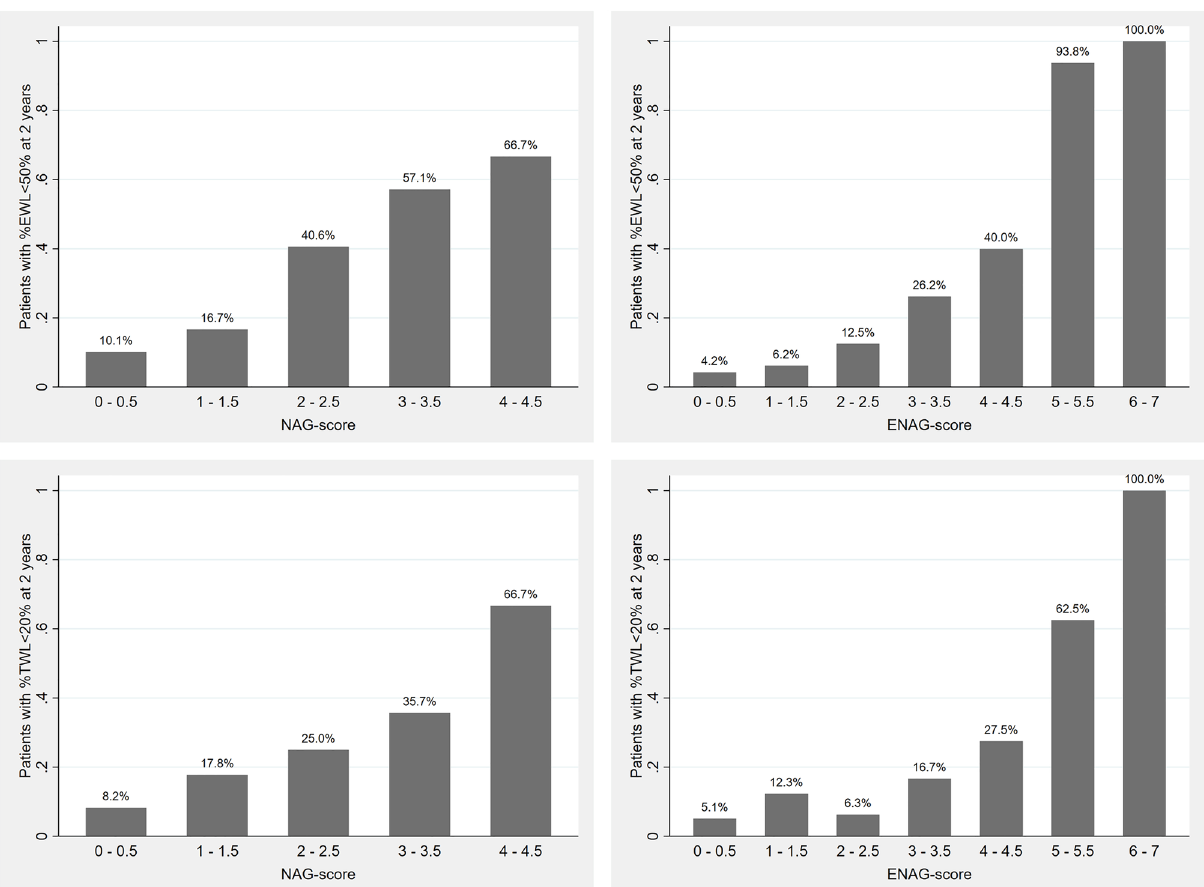
Figure 1. Descriptive graphs of BS unsuccess risk, defined either as %EWL < 50% (upper row) or %TWL < 20% (lower row) at 2 years, according to NAG-score (left column) and ENAG-score (right column). BS bariatric surgery, EWL excess weight loss, TWL total weight